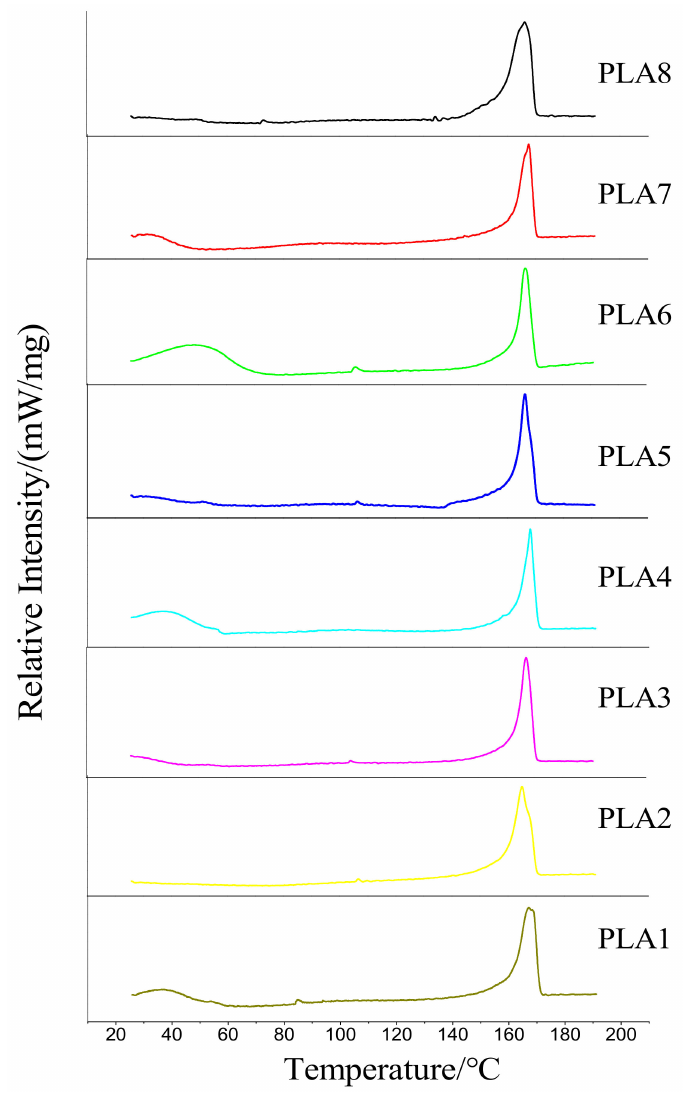
Figure 3. DSC of BSP / PLA Composite Films. Temperature / heat flow diagram. Table 2. Test Data of BSP / PLA Composite